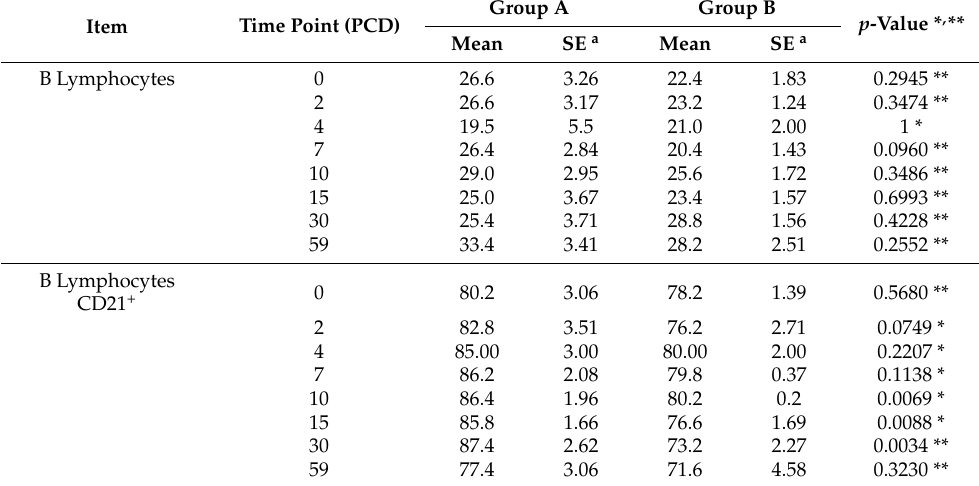
Table 5. Comparison of B and T lymphocyte subset percentages between water buffalo using an inactivated gE-deleted marker vaccine (Group A) and unvaccinated control buffaloes (Group B) after challenge infected with virulent